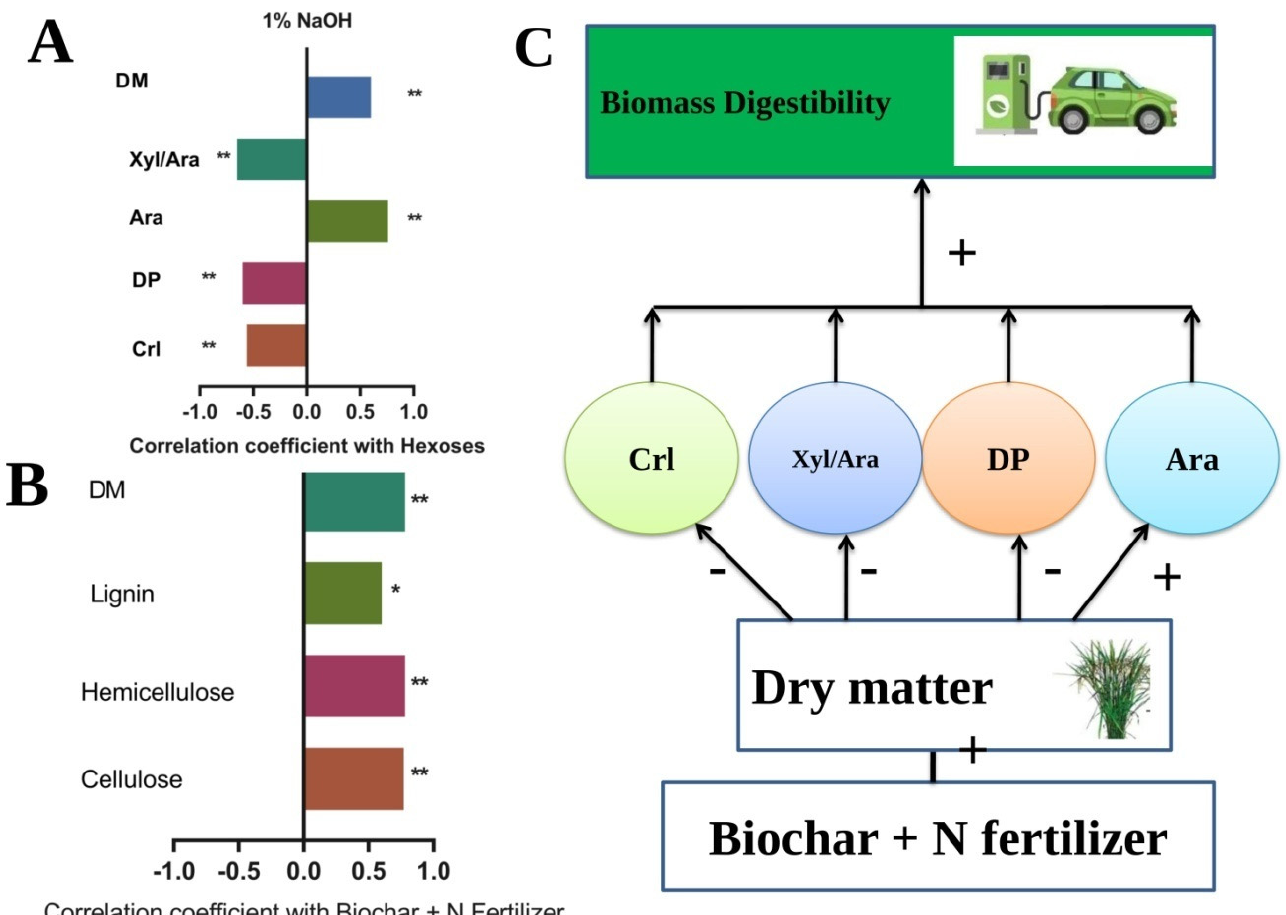
Figure 5. Mechanism involving the primary wall polymer characteristics has an influence on biomass enzymatic saccharification in rice under biochar and nitrogen fertilizer. ( A ) The correlation coefficient between biochar + N fertilizers, cellulose, hemicelluloses, lignin, and DM. ( B ) Correlation analysis between hexoses, Crl, Dp, Ara, Xyl/Ara, and DM. ( C ) A model for improving biomass yield and enzymatic digestibility with biochar and N fertilizer by changing wall polymer characteristics. * and ** indicate a significant coefficient correlation value at p < 0.005 and 0.001. (+) and ( − ) represented increased and reduced effects, respectively.